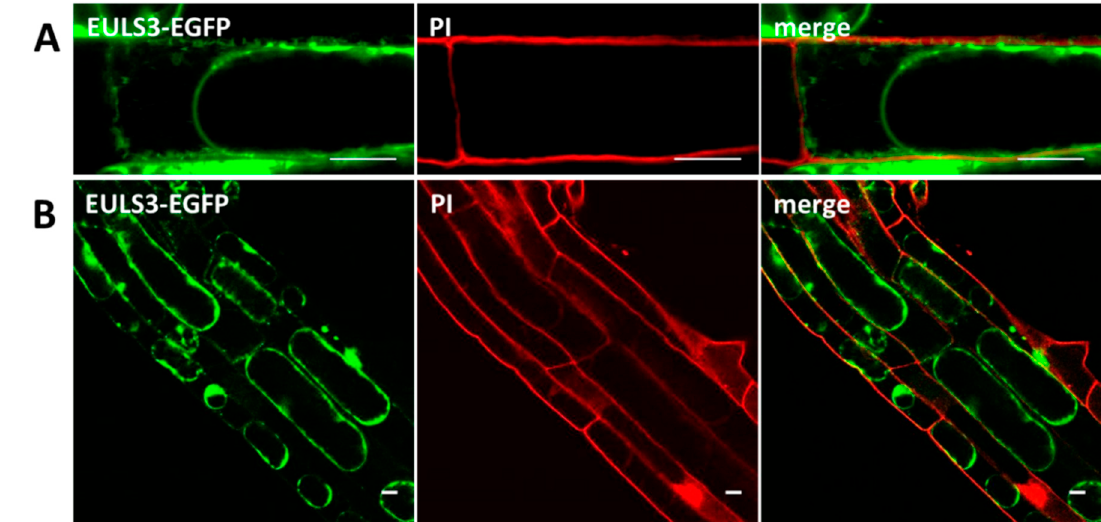
Figure 4. ArathEULS3-EGFP localization in the apoplast. ( A,B ) Confocal images of plasmolyzed root cells showing fluorescence of ArathEULS3-EGFP in the apoplast. Plasmolysis was performed using 0.8 M sorbitol. Confocal images are single slice optical sections. PI and EGFP channels are combined in overlay pictures (merge). Scale bars represent 10 µm.